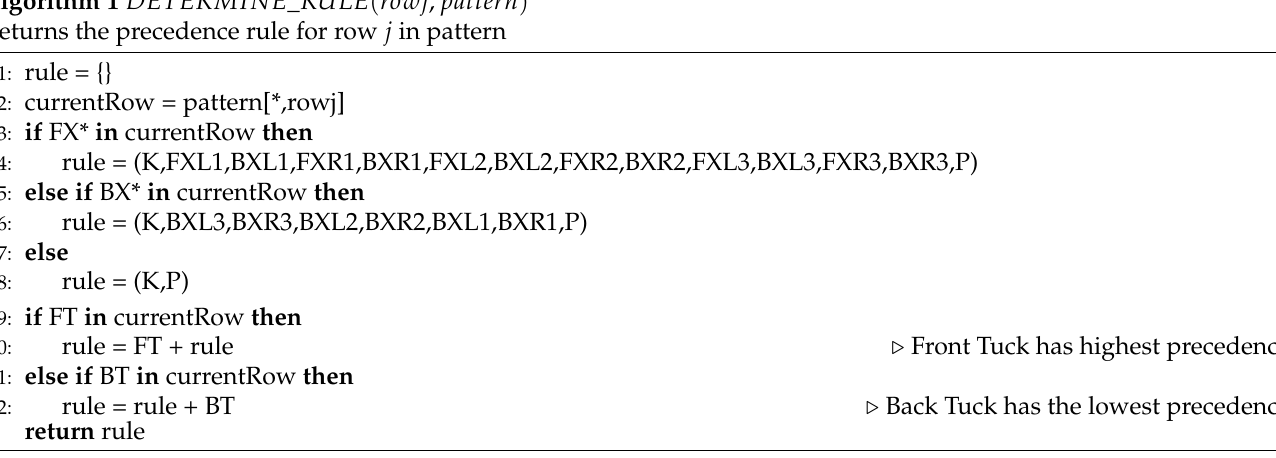
Algorithm 1 DETERMINE _ RULE ( rowj , pattern